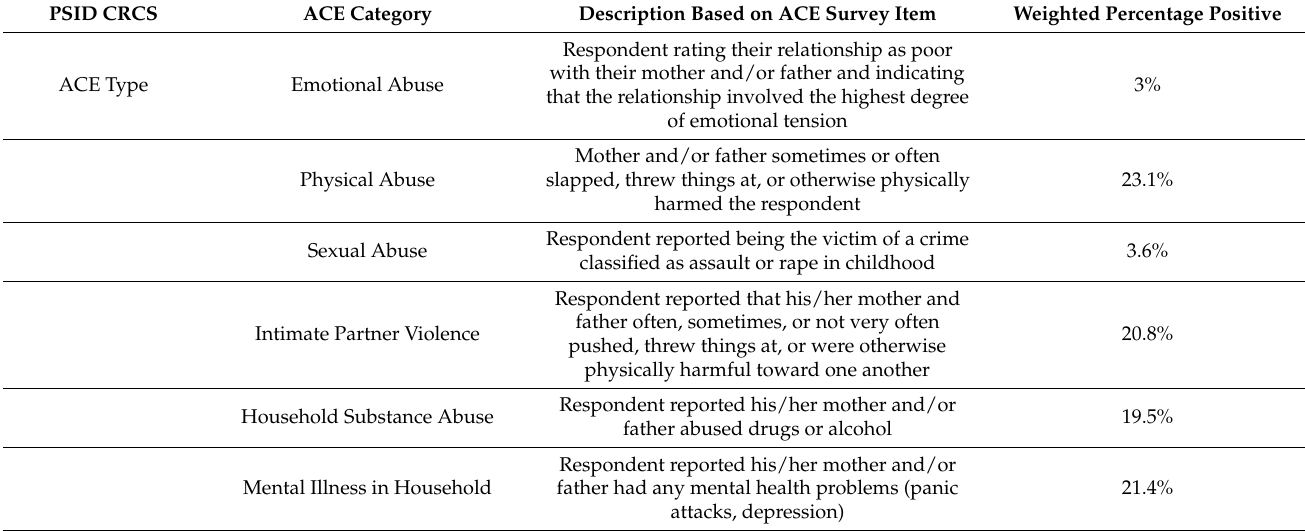
Table 1. Adverse Childhood Experiences (ACE) Categories and Rates of ACEs in Childhood Retrospectives Circumstances Study (2014–2015, n =